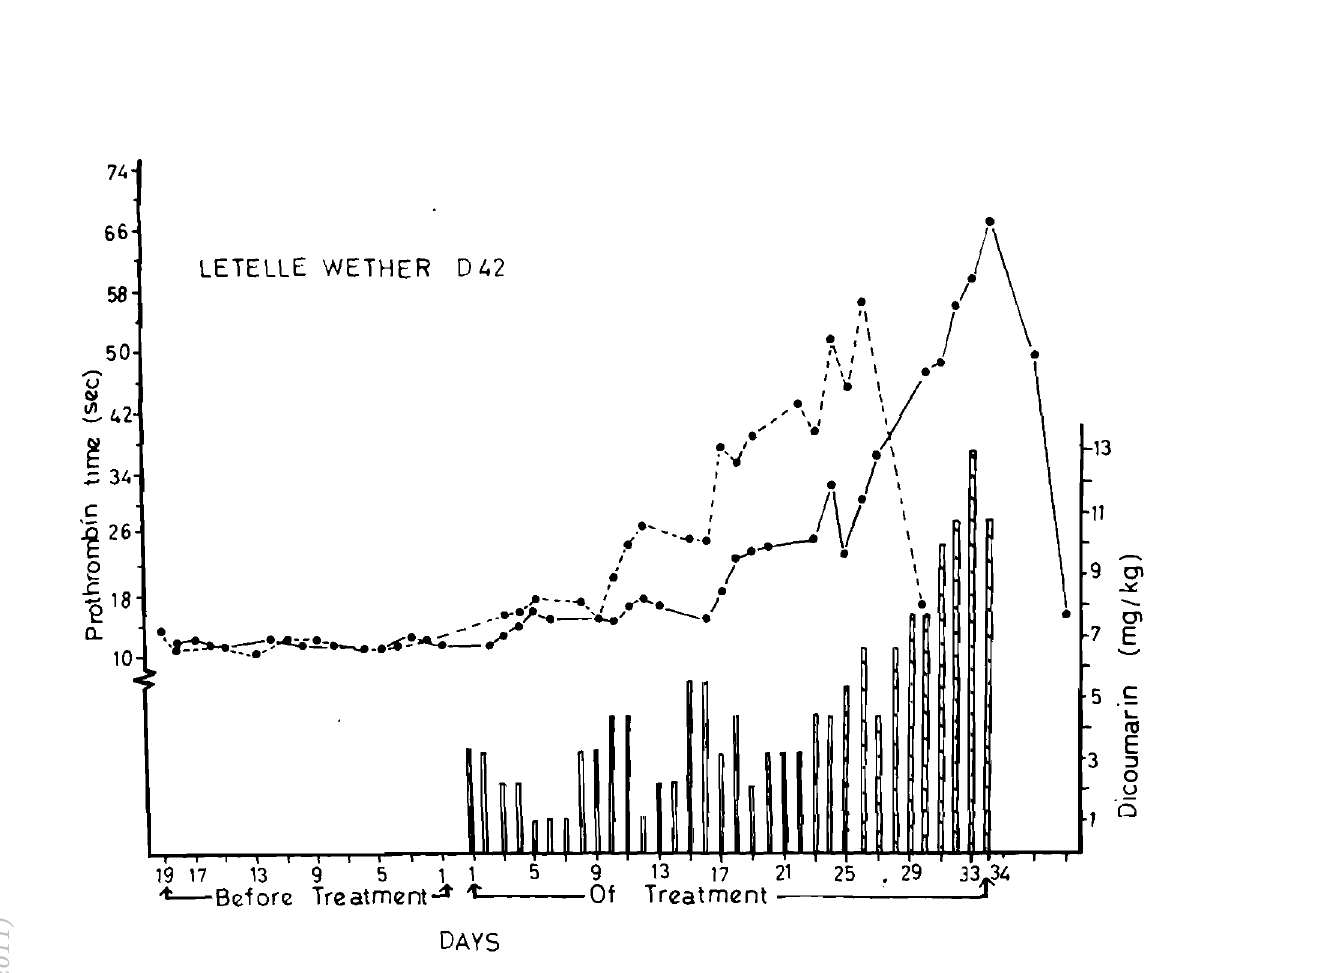
Fig. 6. Prothrombin times of Letelle Wether D42 before and during two periods in which an identical intra ruminal dosing programme (open histograms) was followed up to the 24th day. Nine mg dietary vitamin K was (e- --·e) provided daily in the first period (prothrombin times and 2.7 mg daily in the second period: pro thrombin times